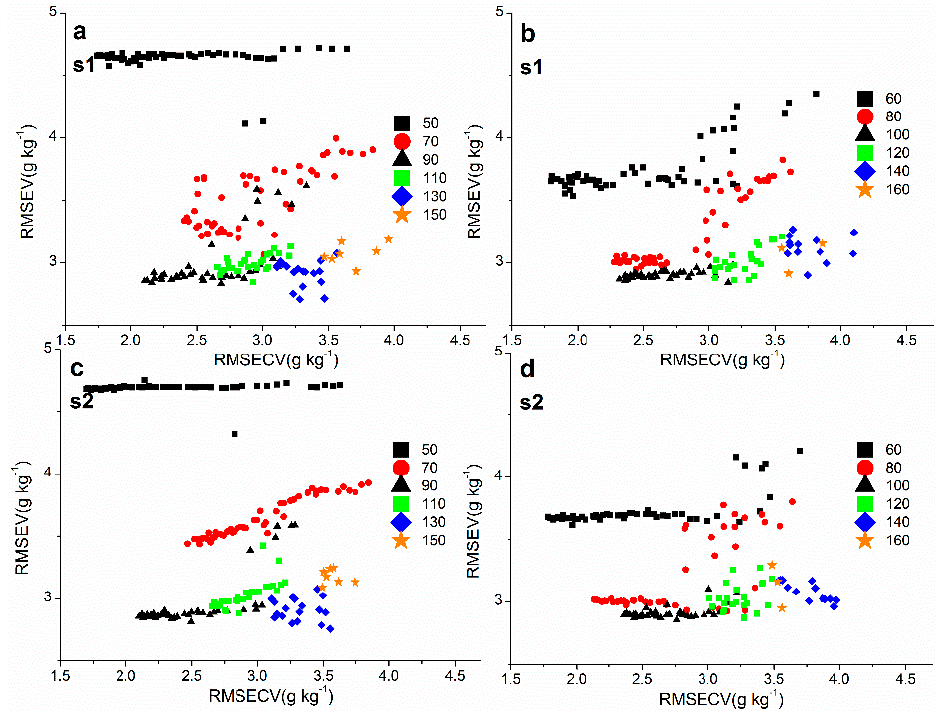
Figure 6. Root mean square error of validation (RMSEV) versus root mean square error of cross-validation (RMSECV) obtained by regressor s1 ( a , b ); and RMSEV versus RMSECV obtained by regressor s2 ( c , d ) in Co-LSSVMR training phases when more than 50 labeled samples are used in calibration.